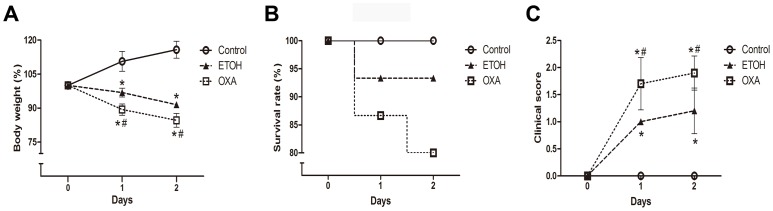
Changes in body weight, survival rate and clinical scores during oxazolone-induced colitis.
A. The OXA mice lost the more body weight on day 2 compared to the ETOH mice. B. An 80% survival rate was observed in the OXA mice. C. The clinical scores of the OXA mice were significantly increased compared to the ETOH mice. n = 15 per group, *p<0.05 versus the control mice, and #
p<0.05 versus the ETOH mice.